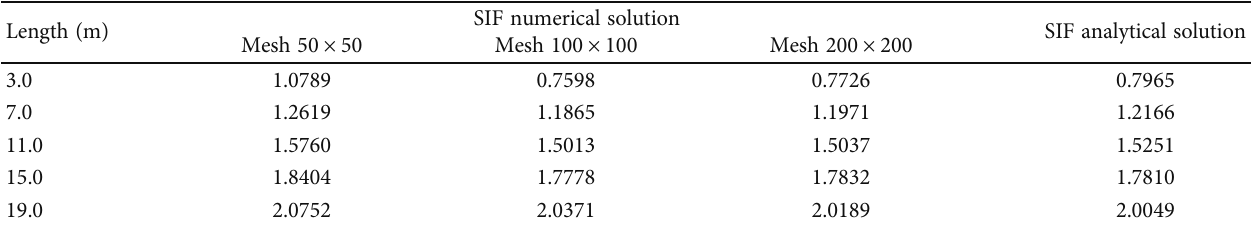
Table 2: Comparison between the SIF values (unit: 10 7 Pa/m 2 ) of the numerical solution with those of the analytical solution for a plate with a central crack.